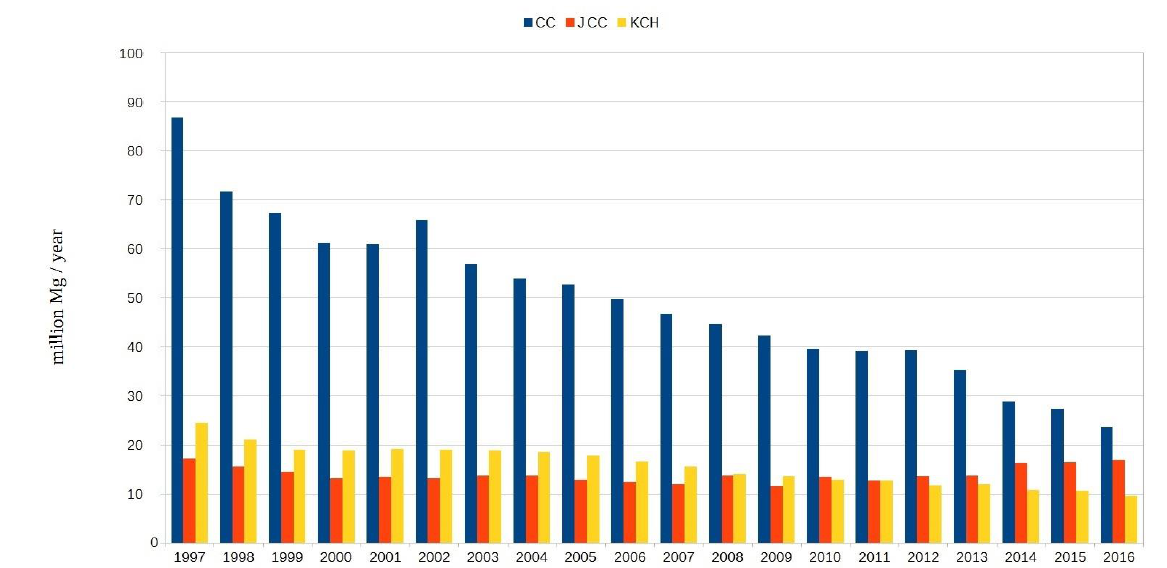
Fig. 5. Hard coal production of the coal